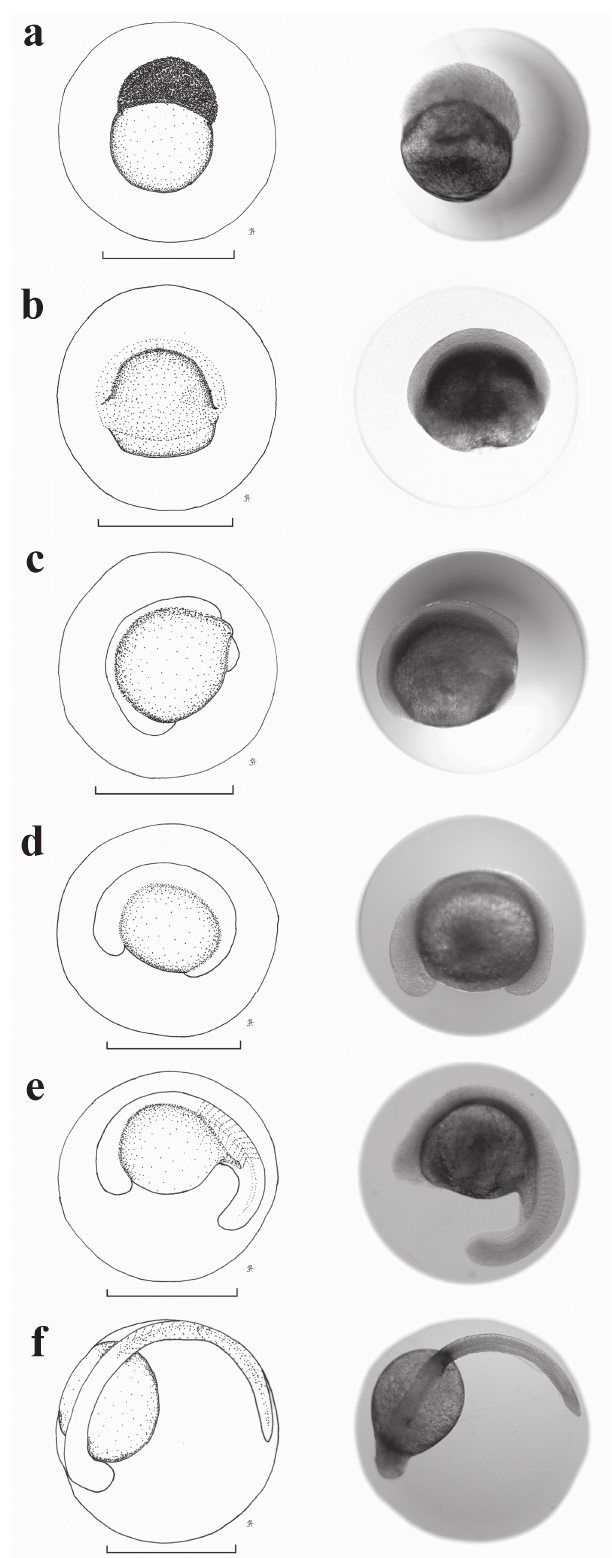
Fig. 3. Drawings and photographs of the embryonic development of Pseudoplatystoma reticulatum . (a) morula, (b) gastrula; (c) initial embryo, (d) tail formation, (e) free tail, and (f) final embryo. Scale = 1